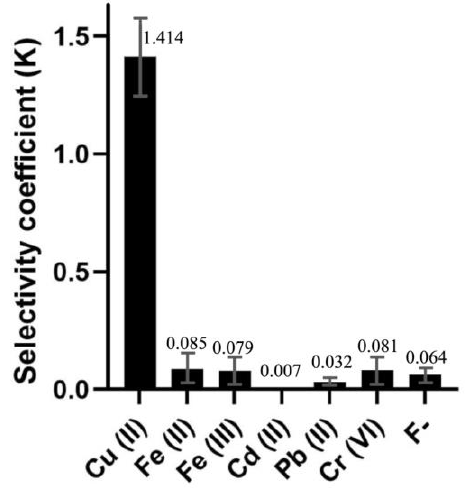
Figure 10. Selectivity data for the different interfering species.